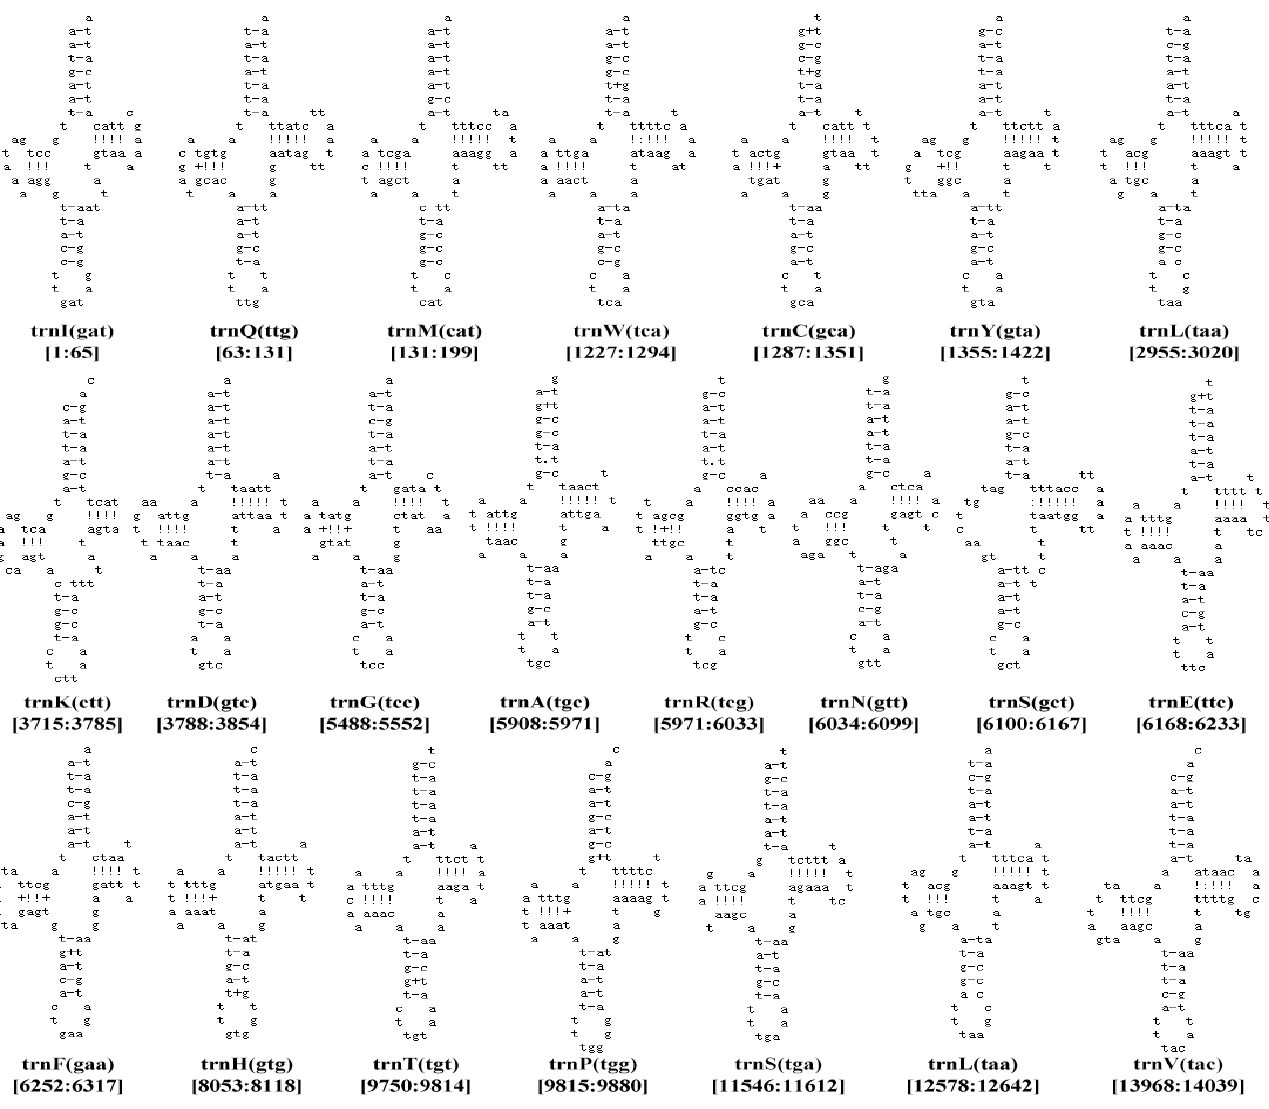
Figure 5. The 22 tRNA secondary structures of P. casei . The numbers below indicate their sequence position in the mt genome.